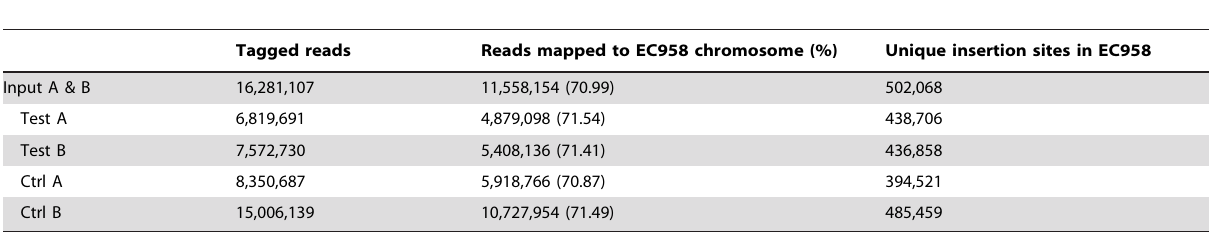
Table 1. Summary of sequencing and mapping results of multiplexed TraDIS